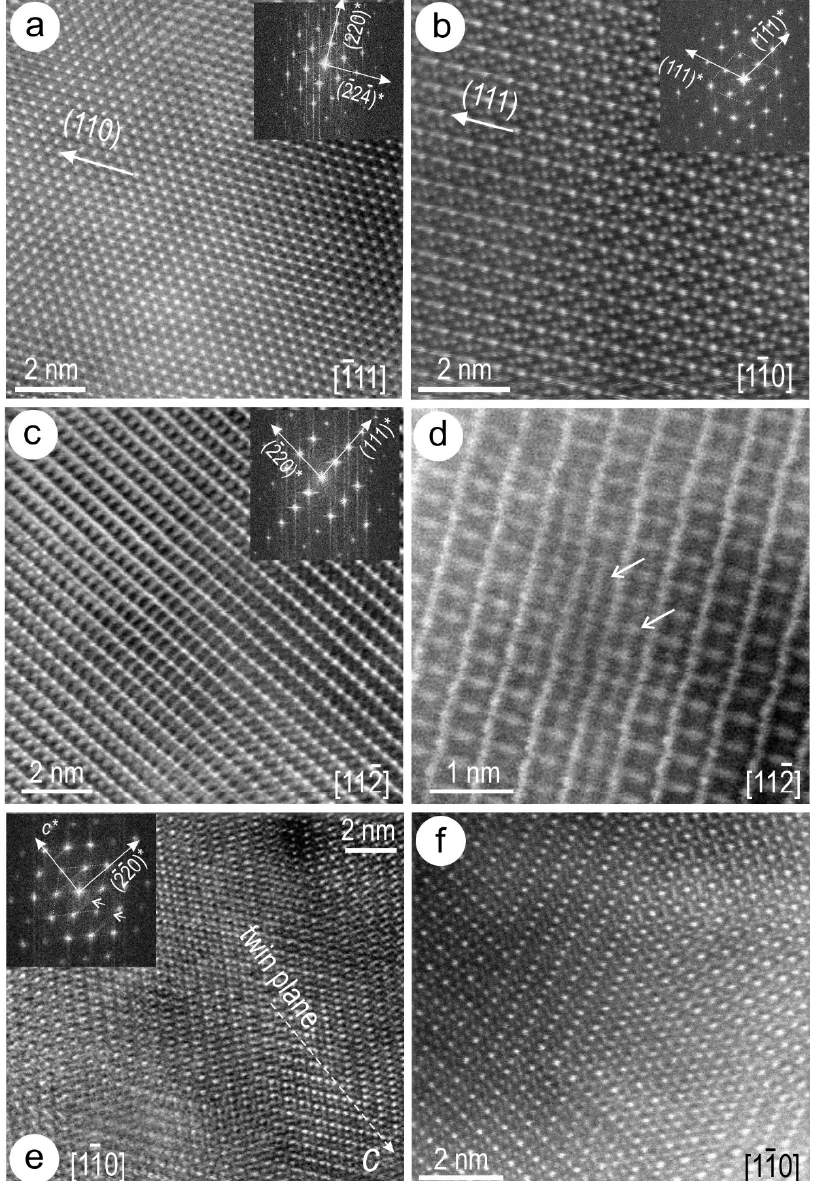
Figure 17. ( a–f ) High-resolution HAADF STEM images and FFTs (insets) of magnetite on zone axes as marked on each image. Note linear defects in image ( d ), the micro-twinning in image ( e ) and nanoscale domains with misorientation in image ( f ) indicating lattice strain close to inclusions. The atom distribution on HAADF STEM images for the [110] , [111] and [112] zone axes in magnetite were assessed by STEM simulation and crystal structure models after calculating the zone axis from SAEDs (Figure 18). Such patterns are reproduced in the STEM simulations with good fit on all three zone axes.